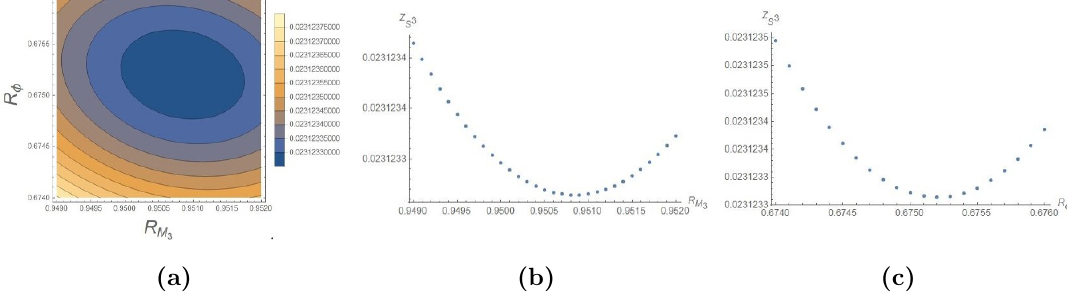
Figure 1. Extremizing the partition function of the ( A 1 ; D 3 ) Lagrangian without the (cid:13)ipping (cid:12)eld (cid:12) . (a) Contour diagram of Z ( A 1 ;D 3 ) vs. f r M ; r (cid:30) g . (b) Plot of Z ( A 1 ;D 3 ) S 3 3 of Z ( A 1 ;D 3 ) vs. r (cid:30) at r M = 1. S 3 3